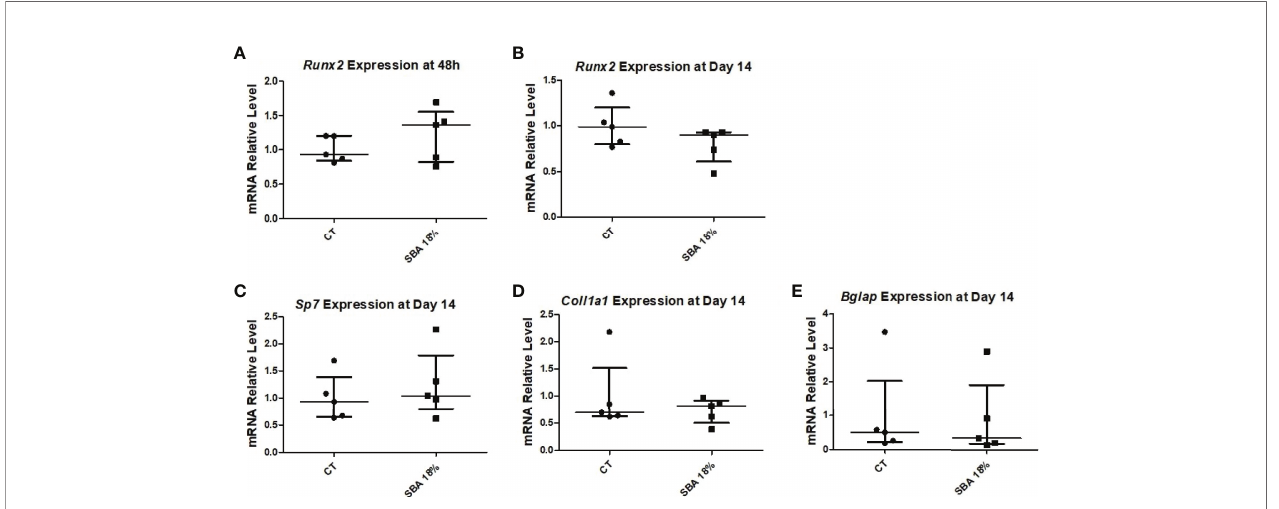
FIGURE 10 | 4-week SBA protocol did not induce changes in osteoblastogenesis. (A, B) Relative mRNA expression level of early osteoblastogenic marker gene (RUNX2) in CT and SBA groups (18%), respectively, cells were cultured for 48 hours in standard growth media and for 14 days were exposed to co-differentiation media, respectively; (C-E) Relative mRNA expression level of other osteoblastogenic marker genes (osterix, collagen1, and osteocalcin, respectively) in CT and SBA (18%) groups after exposure to co-differentiation media for 14 days. Data represent median and interquartile range; n = 5. Statistical analysis was performed using Mann – Whitney ’ s test. Runt-related transcription factor 2 ( Runx2 ), osterix ( Sp7 ), collagen1a1 ( Col1a1 ), osteocalcin ( Bglap